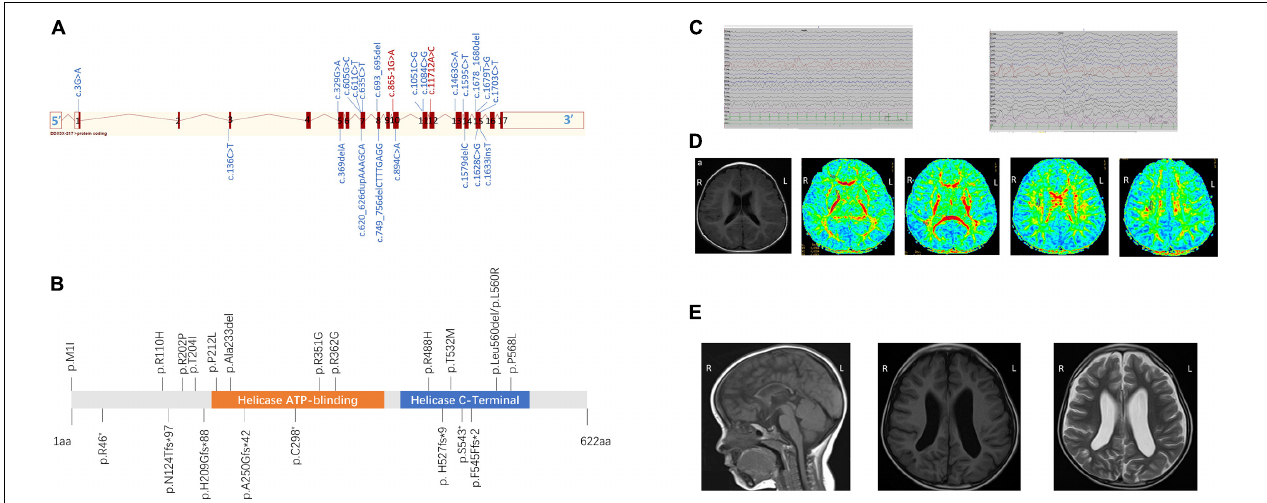
FIGURE 1 | (A) Schematic view of the DDX3X exon structure based on NM_001193416. Red blocks represent exons, and the exon number is listed on each exon. cDNA change is listed for each variant. Splice site mutations are shown in red font. (B) Location of amino acid substitutions in DDX3X (NM_ 001193416.2). Missense and in-frame deletions (top, 13), frameshift, and non-sense variants (bottom, 8). DDX3X contains two subdomains, a helicase ATP-binding domain (orange bar) and a helicase C-terminal domain (blue bar). (C) The latest electroencephalogram (EEG) and of Female 17. Abnormal EEG presentation, multiple slow waves in bilateral occipital lobes. (D) Brain magnetic resonance imaging (MRI) of Female 19 at the age of 1 year and 1 month (A–E) Axial position T1-weighted images show normal sulci and gyri, Axial position diffusion tensor imaging (DTI) images show delayed of white matter of frontal lobe and centrum semiovale myelination. Numbers 1–8 represent genu of the corpus callosum, white matter of the frontal lobe, anterior limb of the internal capsule, posterior limb of the internal capsule, splenium of the corpus callosum, occipital lobe, and centrum semiovale (7 and 8), respectively. (E) Sagittal image shows diffuse thinning of the corpus callosum of Female 13 at the age of 1 year and 3 months (A) . MRI (B) T1 and (C) T2 axial slices showed widened bilateral lateral ventricles of Female 6 at the age of 3 years and 10